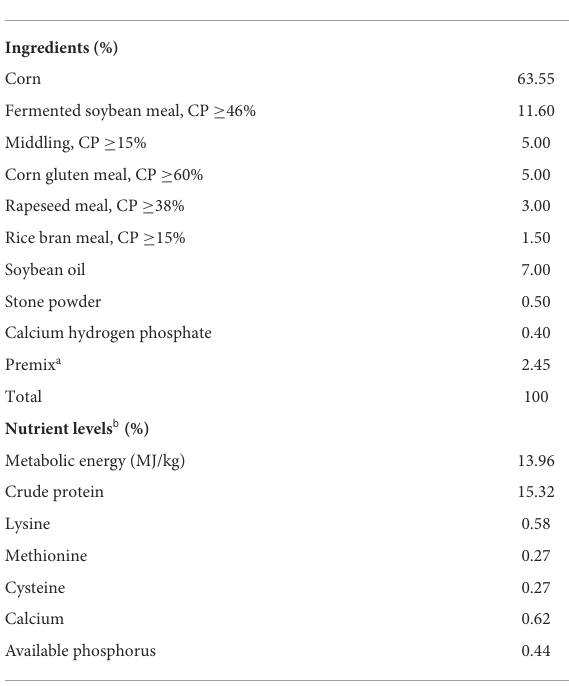
TABLE 1 Ingredient and nutrient levels of basal diet